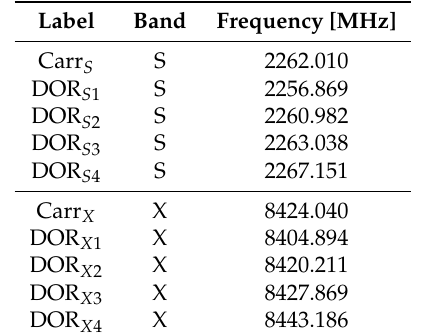
Table 2. Carrier and Differential One-way Ranging (DOR) tone frequencies of the APOD VLBI signal in the S- and